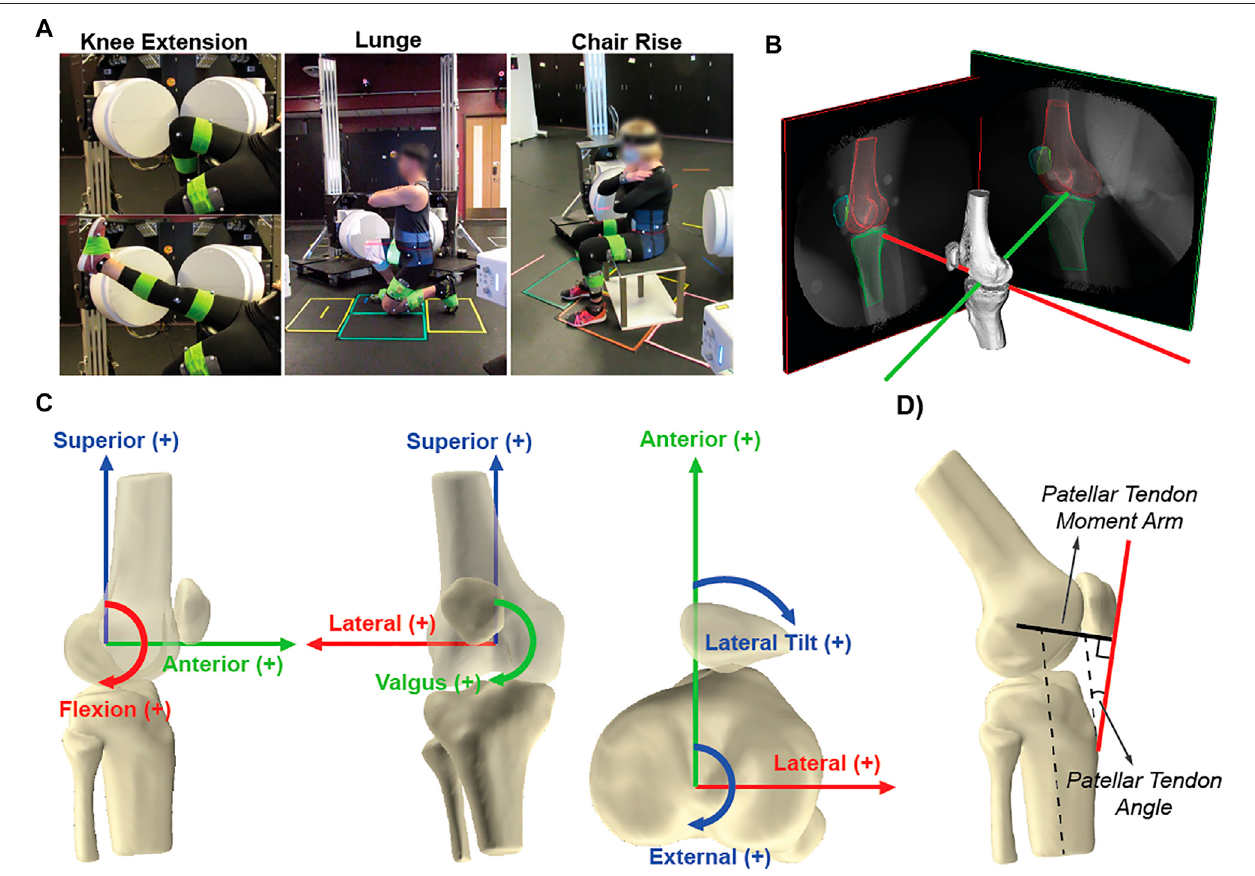
FIGURE 1 | (A) Participants performed seated knee extension, rising from a chair, and lunge with their dominant knee in view of the radiography system, and (B) Representative bone tracking of the femur, patella, and tibia in high-speed stereo radiography (HSSR). (C) origin of the femoral coordinate system for each subject was de fi nedby fi ttingacylindertothemedialandlateralposteriorcondyles,withthecenterplacedatthetrochlea.Thecoordinatesystemofthetibiaandpatellawasassigned coincidentwiththefemoralcoordinatesystematfullextension; (D) patellartendonangle(PTA)wastakenasthelinebetweentheinferiorpoleofthepatella,thetibial tuberosity, and the long axis of the tibia, and moment arm (PTMA) was calculated as the perpendicular distance from the patellar tendon to the instantaneous axis of rotation of the tibiofemoral